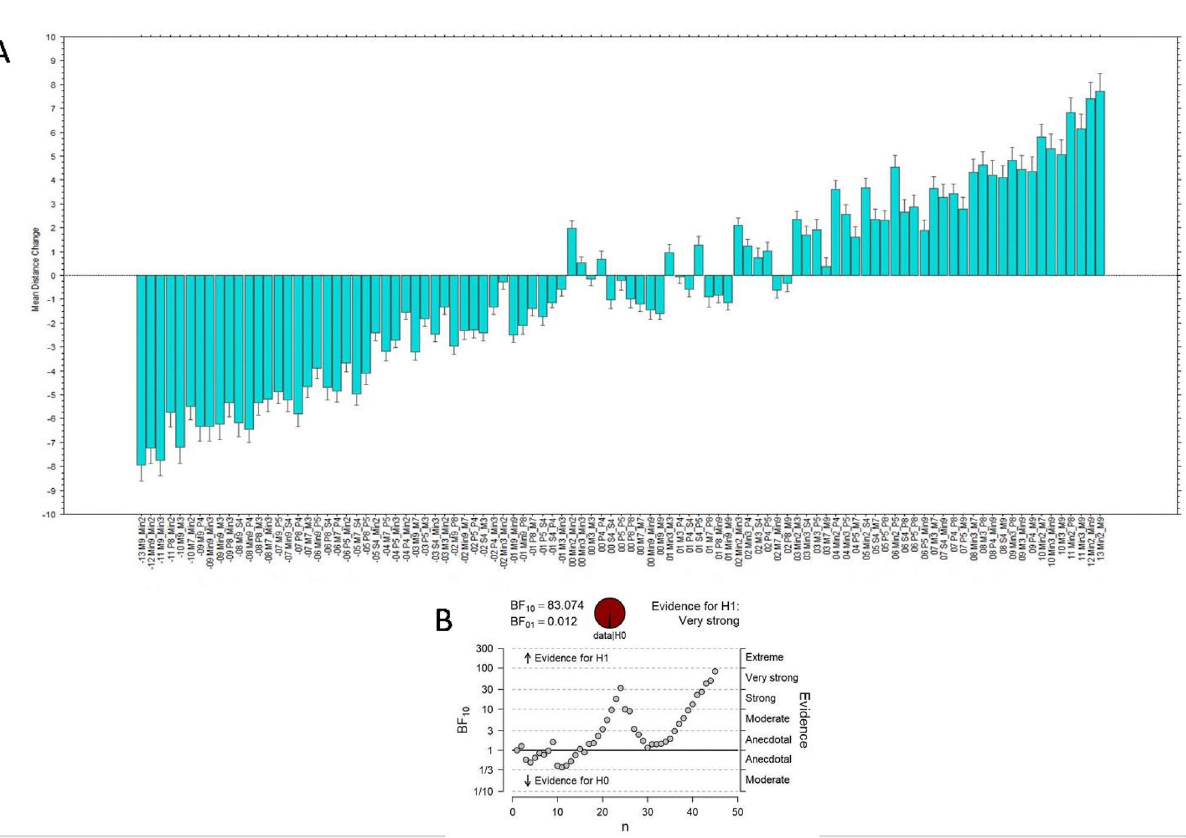
Figure 3. Experiment 1. ( A ) Bar graph of the perceived mean distance change, arranged by AV Semitone Distance (varying from − 13 to 13) and collapsed over Singers 1 and 2. Error bars are 95% confidence intervals. ( B ) Bayesian t-test sequential analysis of absolute mean distance change for Larger Seen Interval versus Smaller Seen